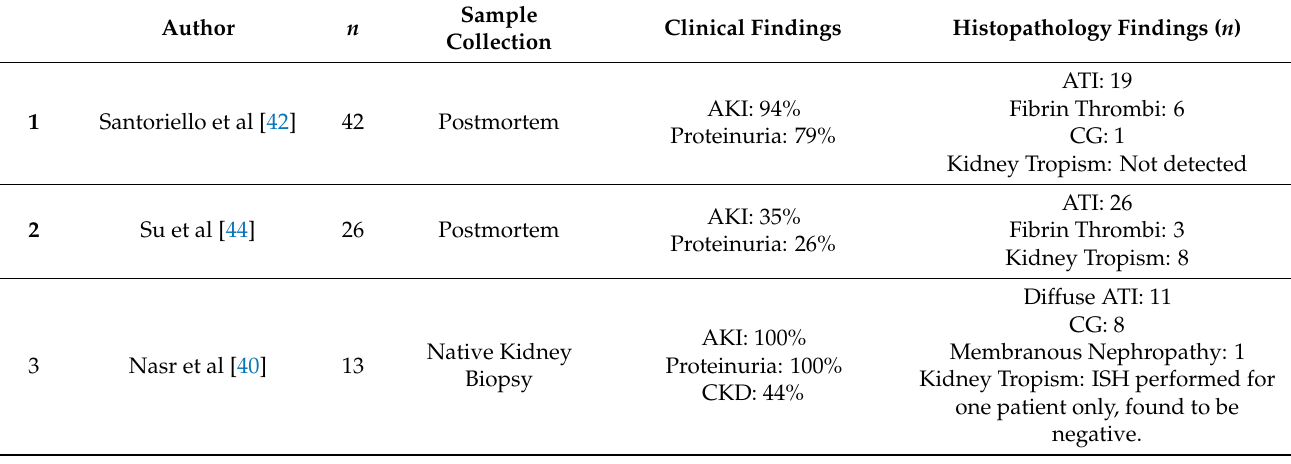
Table 2. Common histopathology findings in CoV-AKI biopsy or autopsy series. Percentage of clinical findings is based on number of available data and not on the total of patients in the study. Kidney tropism was determined based on the author’s interpretation, presence of definitive viral like particles in electron microscopy (EM), or molecular evidence of the virus by either immunofluorescence (IF) staining or in situ hybridization